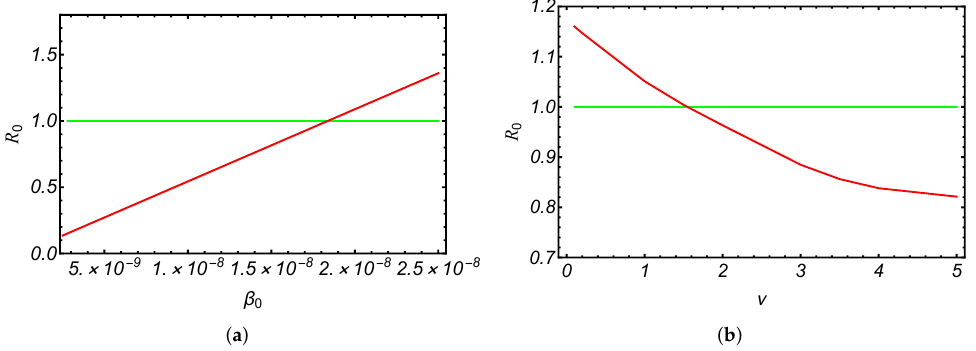
Figure 6. The curve of the basic reproduction number R 0 is shown in red, plotted against ( a ) the baseline contact rate β 0 and ( b ) the incubation rate ν . The green line represents R 0 =